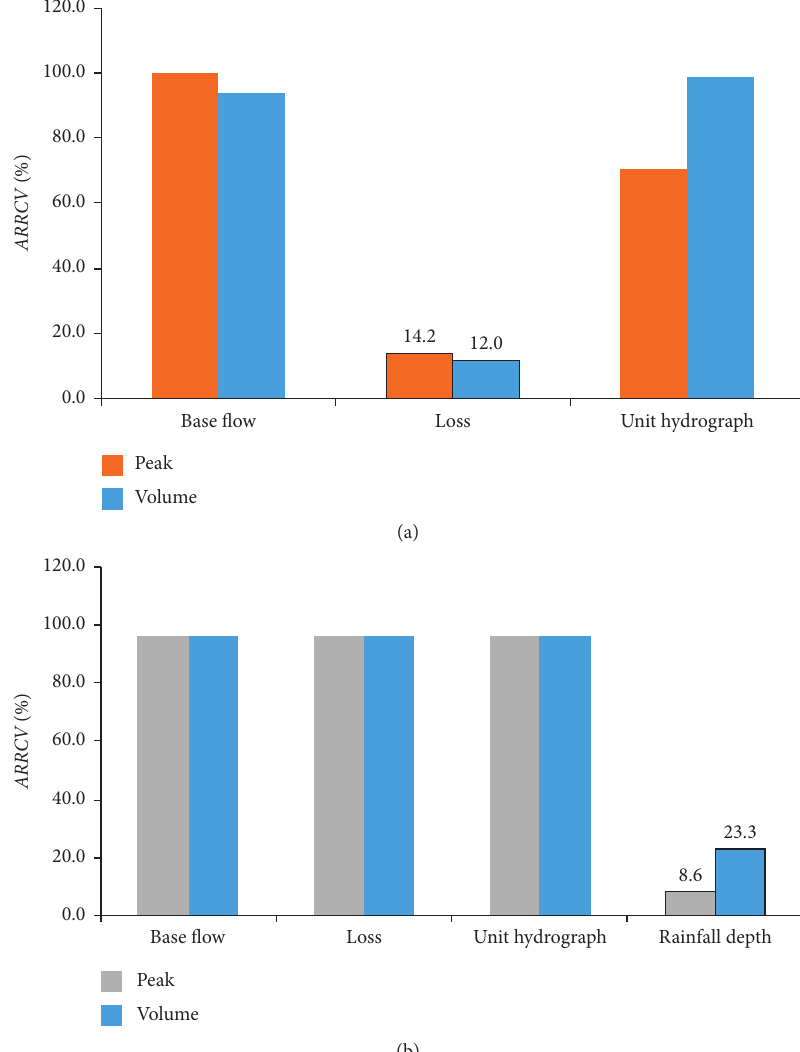
Figure 5: The ARRCV (in percentage) obtained for different hydrological components (baseflow, loss, unit hydrograph, and rainfall